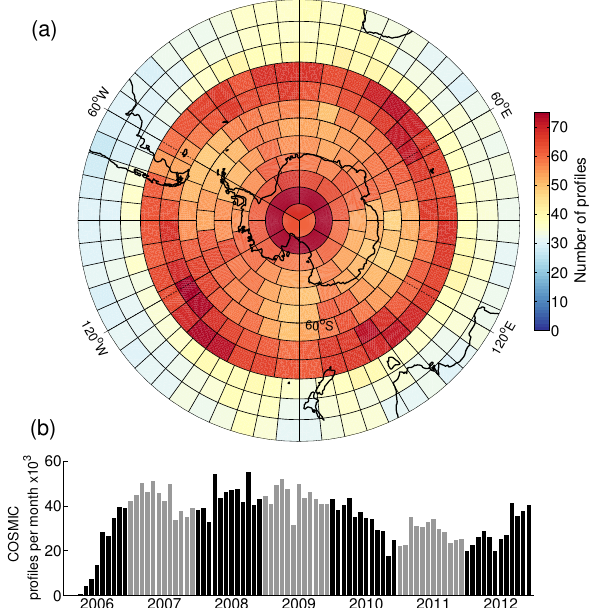
Figure 1. Polar stereographic projection of monthly-mean COS- MIC sampling density for the period 2007–2012 (a) and total num- ber of occultations per month for the period 2006–2012 (b) . Each box in (a) represents an equal area of approximately 550km 2 . Al- ternating years in (b) are shown by black and grey